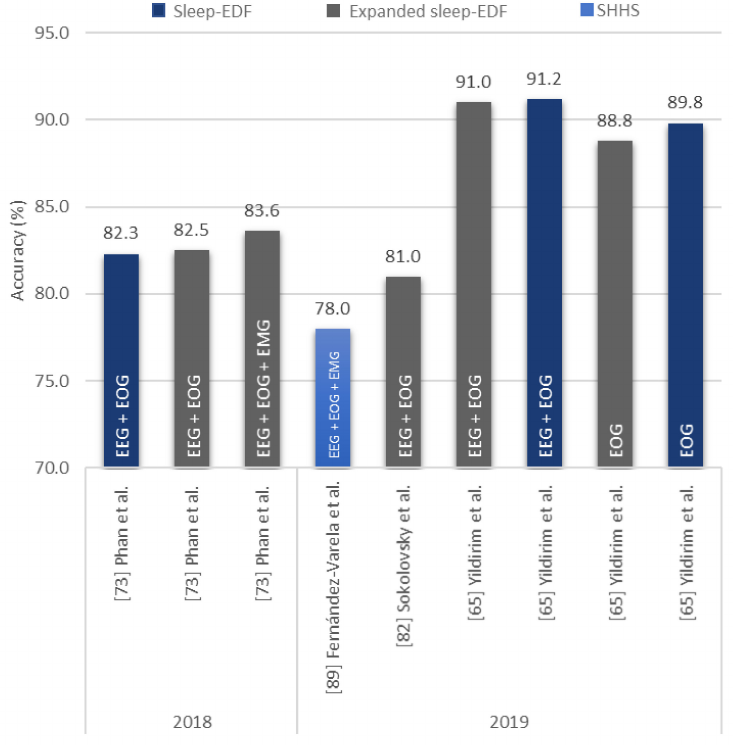
Figure 11. Sleep stage classification accuracy of CNN-based models based on stand-alone EOG signals or a mixture of EEG, EOG, and / or EMG signals. Various sleep datasets are represented by di ff erent colors and the type of signals described in the bar chart. * Summary statistics: Using EEG + other signals / EOG in